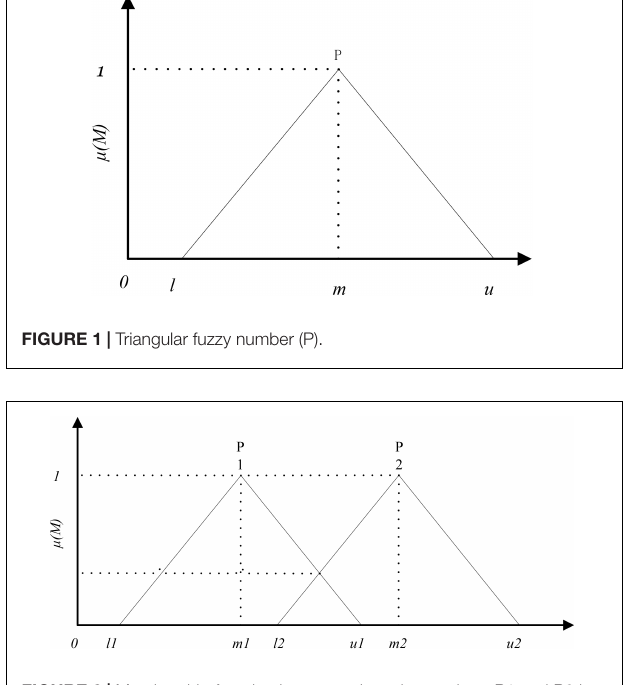
FIGURE 2 | Membership function between triangular numbers P1 and P2 in the fuzzy evaluation matrix.